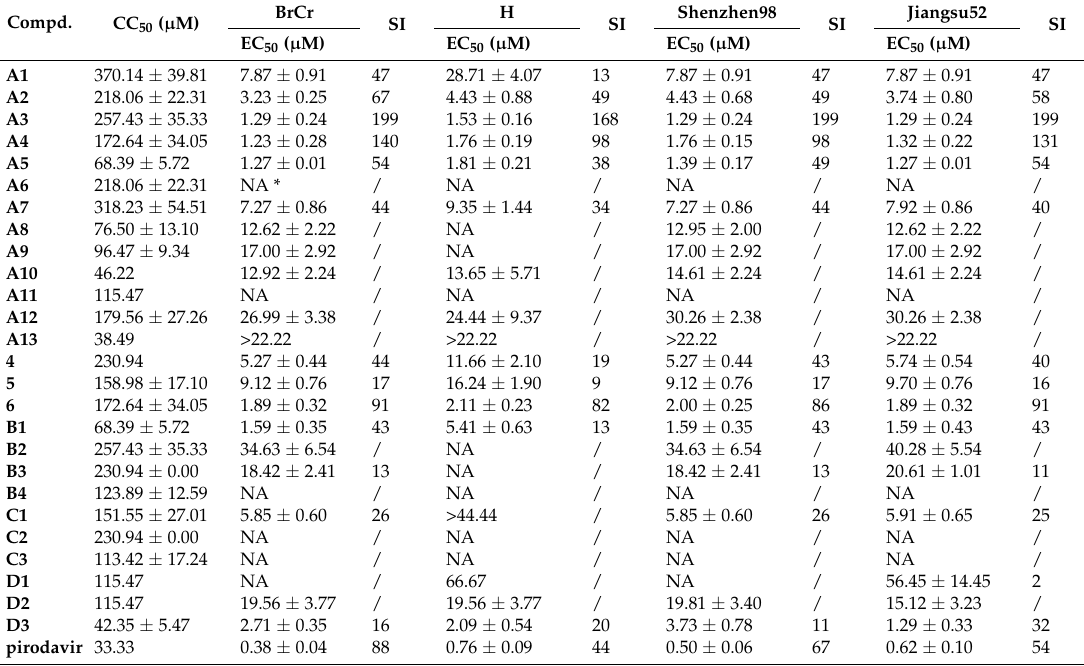
Table 1. Antiviral activity of tested compounds towards four enterovirus A71 (EV-A71) clinical isolates in vitro.